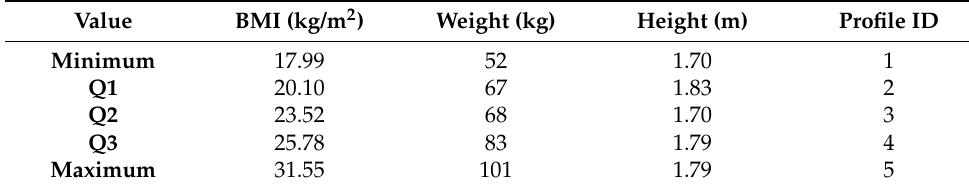
Figure 10. Months in which participants use the Taltech Campus ( a ) and considered summer months ( b ). In terms of preferred weather conditions (Figure 10), the overall perfect summer day according to most participants include the following weather conditions: medium solar radiation (75%) (Uvi = 3–5) (Figure 11a), medium temperature (60.7%) (20–25.9 °C) (Figure 11b), medium relative humidity (57.1%) (40–60%) (Figure 11c), no rain (82.1%) (Figure 11d), gentle breeze (wind speed < 4 m/s) (Figure 11e), and full clear sky (50%) (Figure 11f). Furthermore, we consider these weather conditions in the next simulation-based CFD analysis as the input weather data based on measured campus microclimatic data and Tallinn climatic data. Different weather conditions than these ones might not encourage participants to spend time in the outdoor areas of the Campus, and therefore the analysis of the outdoor thermal comfort is not as relevant as under preferred weather conditions.